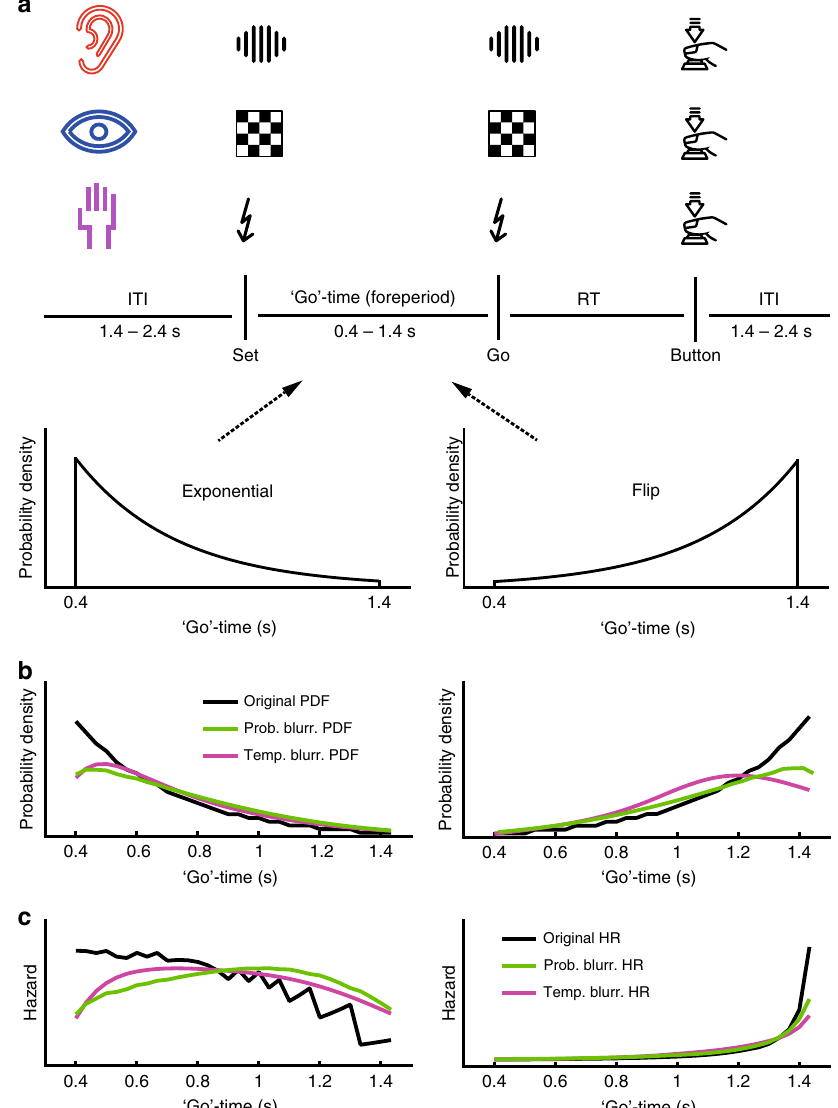
Fig. 2 Task and presented probabilistic structures. a Schematic of ‘ set ’ - ‘ go ’ task. In auditory, visual, and somatosensory blocks of ‘ set ’ - ‘ go ’ trials, subjects were asked to respond as fast as possible to the ‘ go ’ cue by pressing a button with their right index fi nger. In 9.09% of trials, no ‘ go ’ cue was presented (catch trials) in which case subjects were asked not to respond. The time between ‘ set ’ and ‘ go ’ (the ‘ go ’ time) varied systematically. Within a block of trials the ‘ go ’ time was drawn from either a truncated exponential distribution (PD Exp ) or its left-right fl ipped counterpart (PD Flip ). b The two presented event PDFs, PD Exp and PD Flip , in their original, temporally, and probabilistically blurred versions (see Methods). c The hazard rates (HR) of PDF Exp and PDF Flip in their original, temporally, and probabilistically blurred versions (see Methods). ( “ Press Button Halfway Icon ” created by H Alberto Gongora via the Noun Project (thenounproject.com/term/press-button-halfway/637743) licensed as Creative Commons